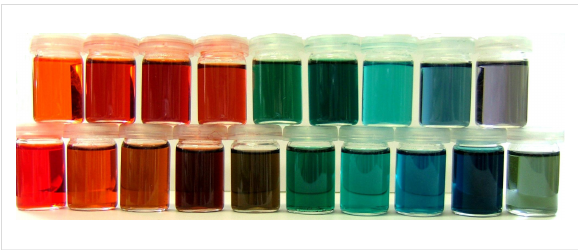
In this way, it is possible to create all color shades and nuances that are needed to replicate human irides, such as blue, green, brown and even gray. It is possible to print different color shades by using the synthesized functional dyes, which can then be polymerized afterwards [37-40]. Thus, a color design can be permanently included into polymeric materials, such as ma- terials used for iris implants or other medical